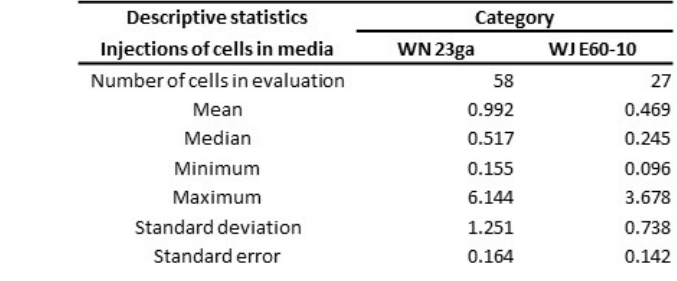
Figure 4. Cellular elasticity after cell injections by WN versus WJ. Boxplots (medians, minimum, maximum) of the stiffness (kPa) measured by atomic force microscopy for WN and WJ-injected pADSCs in capture fluid are depicted. The WN-injected cell monolayers revealed a higher stiffness when compared to the WJ group. Descriptive statistics of Young’s moduli in WN and WJ-injected cells in capture fluid. Medians with minimum and maximum, means, standard deviations and standard errors of the mean of both groups are depicted. *** p < 0.001. Abbreviations: WJ—waterjet, WN—Williams needle.